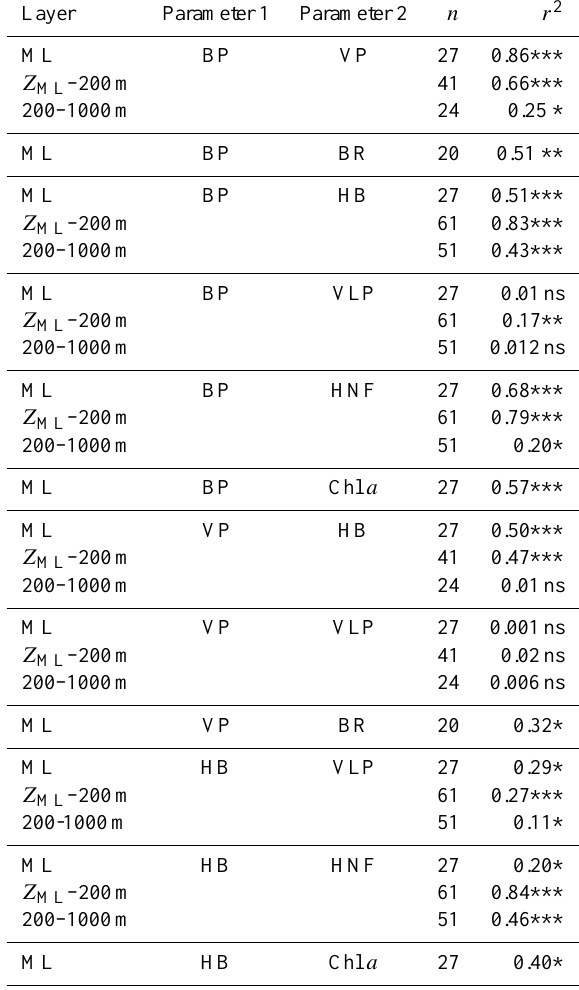
Table 6. Determination coefficients ( r 2 ) of log-log linear regres- sions of bacterial heterotrophic production (BP), viral production (VP), virus-like particles (VLPs), heterotrophic bacterial abundance (HB), heterotrophic nanoflagellates abundances (HNF) and chloro- phyll a (Chl a) . ML: mixed layer, *: p <0.05, **: p <0.001 ***: p <0.0001, ns: not